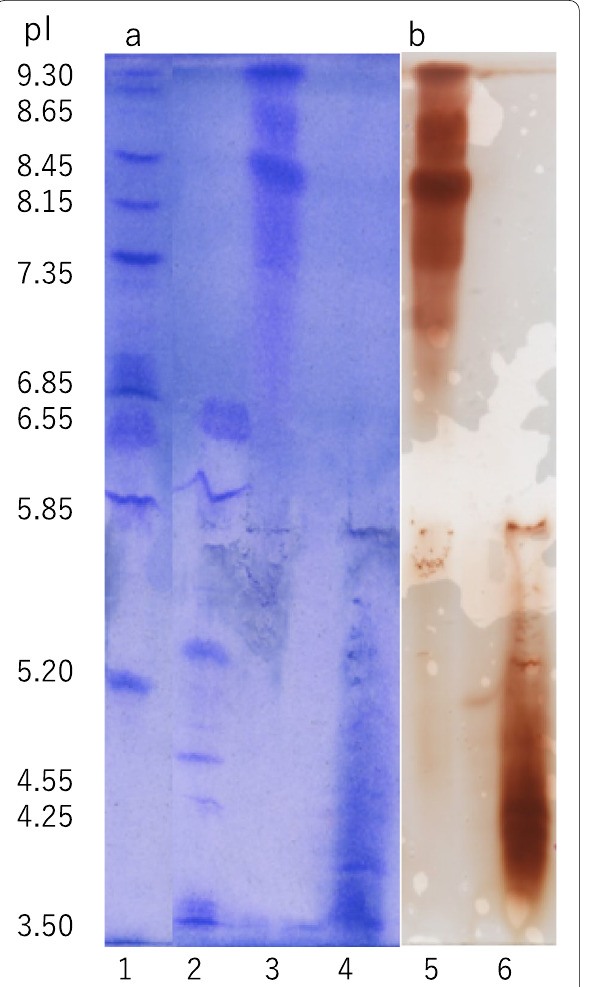
Fig. 5 Isoelectric focusing of blue and yellow fraction. a Stained with Coomassie Blue R 250; b stained with guaiacol. 1, high pI marker; 2, low pI marker; 3, blue fraction; 4, yellow fraction; 5, blue fraction; 6, yellow fraction